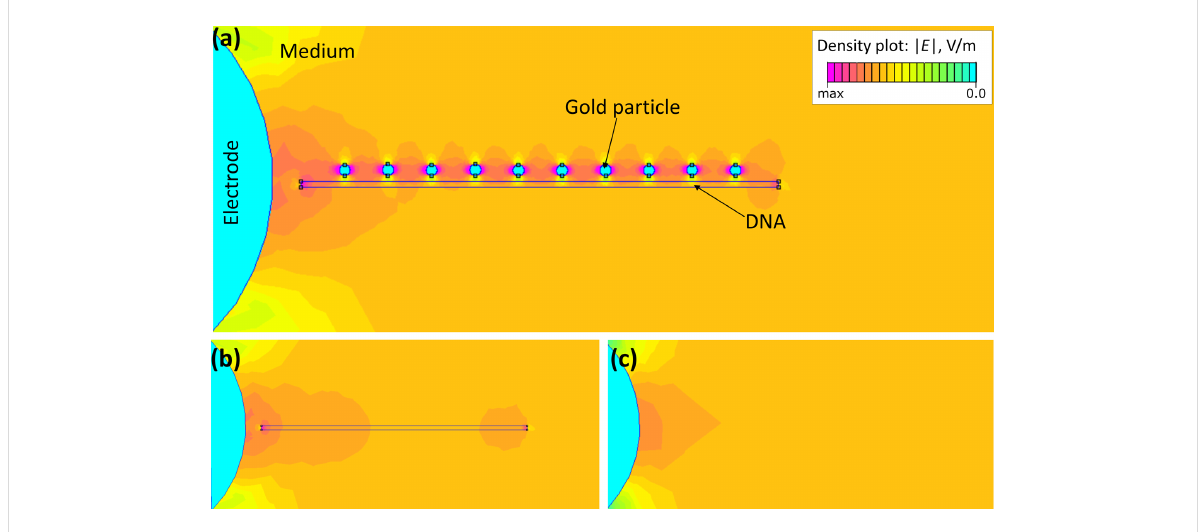
Figure 5: Electrical field intensity (a) in the presence of a gold-nanoparticle modified DNA structure, (b) plain DNA structure at the left electrode, and (c) absence of a DNA nanostructure as obtained from finite element method simulations.